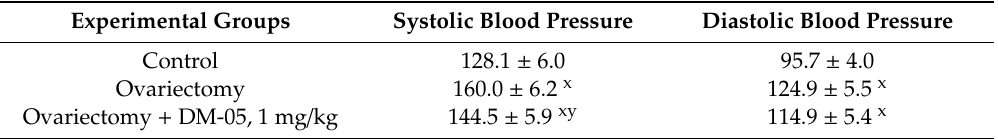
Table 1. The values of systolic (SBP) and diastolic blood pressure (DBP) in animal groups with hypoestrogen-induced endothelial dysfunction and its correction by furostanol glycosides from